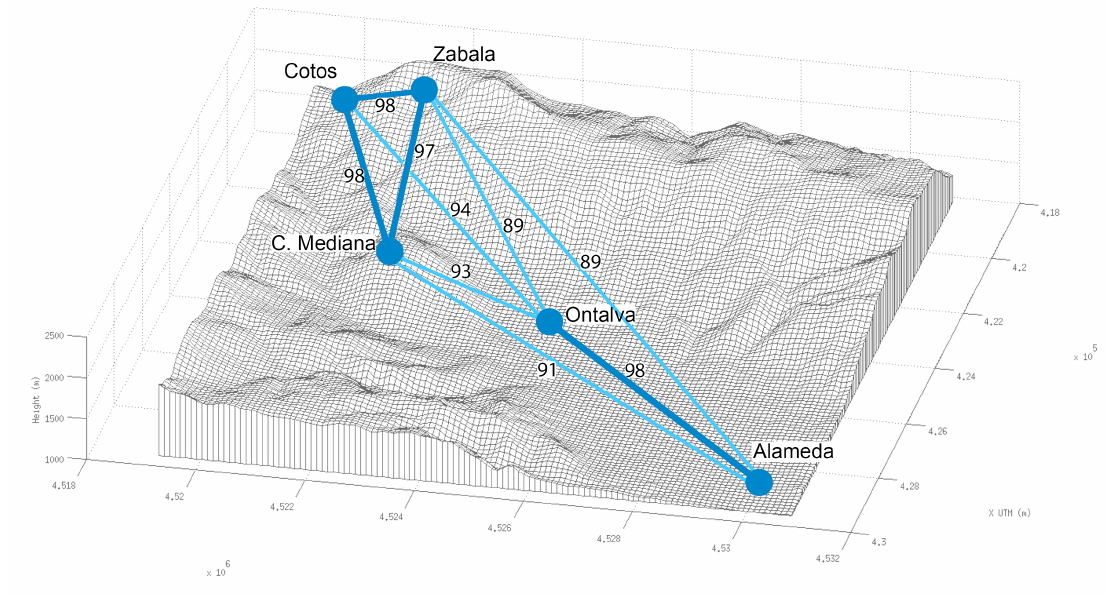
Figure 6. Correlation coefficients of air temperature 10 min time series between all the sites of the network. Width of the lines is proportional to the Pearson correlation factor